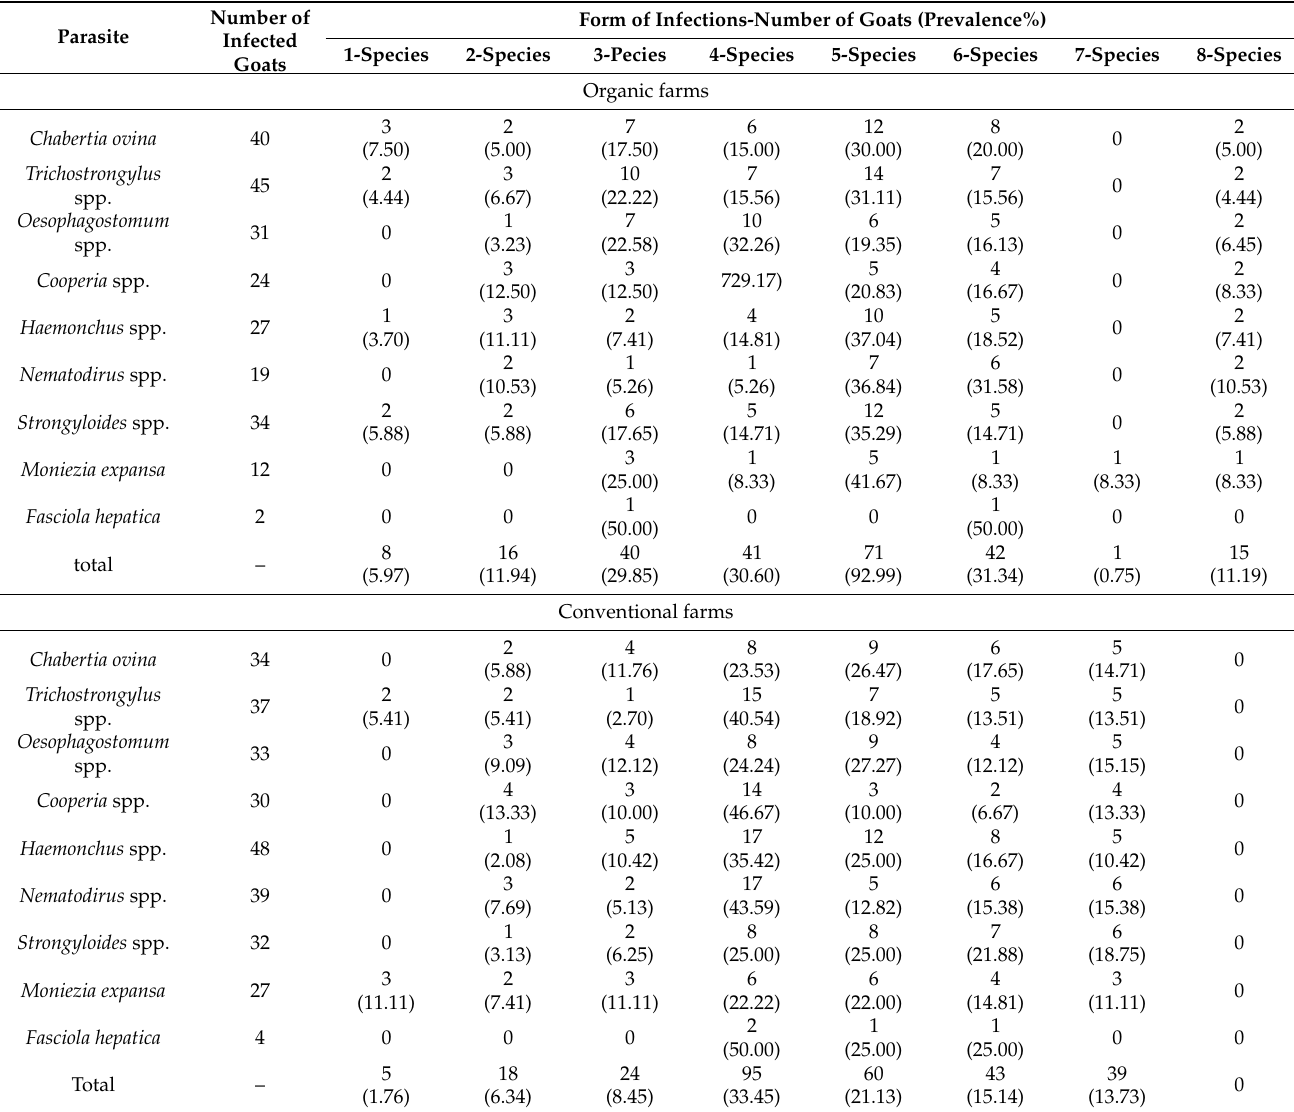
Table 7. Occurrence of particular species of helminths in single and multi-species infections in goats on organic and conventional